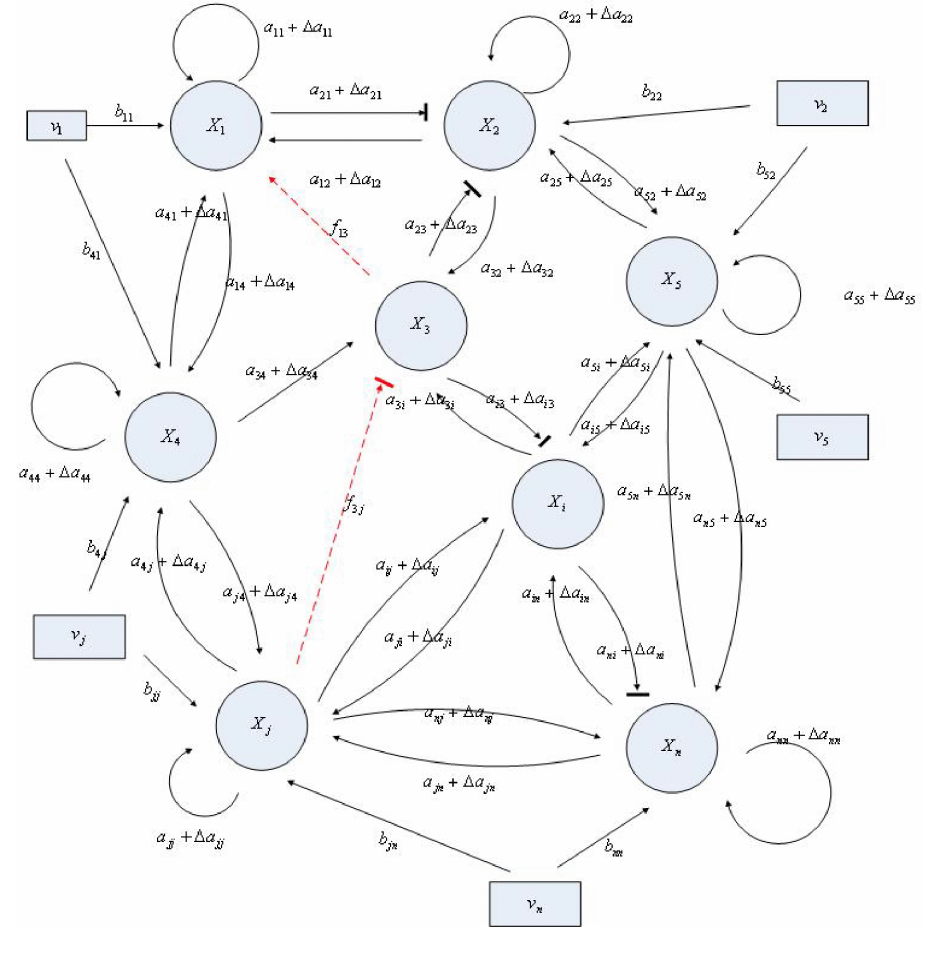
denotes the biochemical circuit design from x f i ij